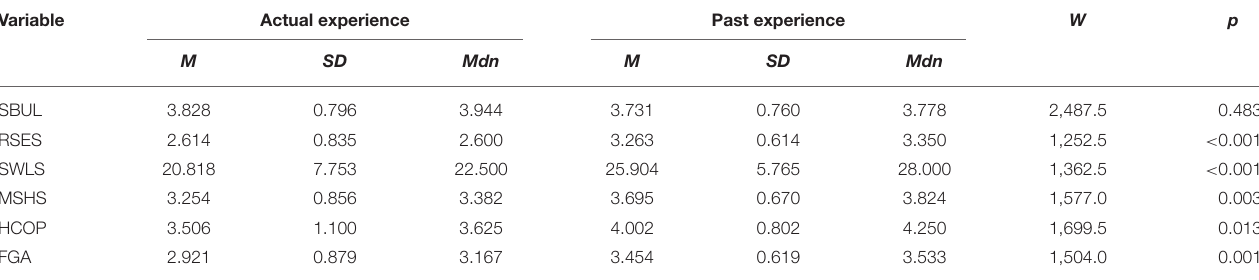
TABLE 2 | Location parameters of the main study variables for the subsamples with actual and past experience of unrequited love compared by Mann-Whitney-U-Test. Variable Actual